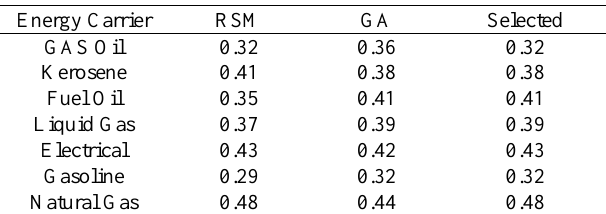
Table 5. Optimized coefficient of momentum for the created networks.